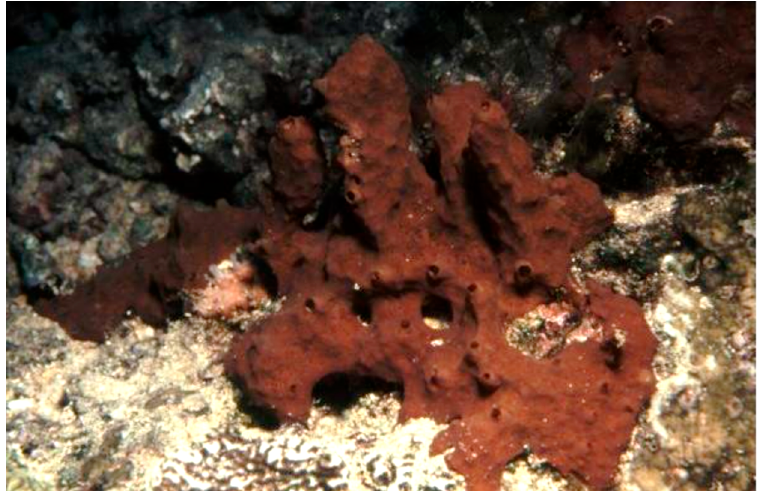
Figure 1. Specimens of Aplysinella rhax demosponge (CC BY 3.0 AU). https://bie.ala.org.au/species/urn:lsid:biodiversity.org.au:afd.taxon:e5607759-f60b-453a-b37a- 30f3726d03c2#gallery. Psammaplysilla purpurea , currently Pseudoceratina purpurea (Carter, 1880; Demospongiae, Verongiida: Pseudoceratinidae), is a subtropical, sessile, filter-feeder, and hermaphroditic